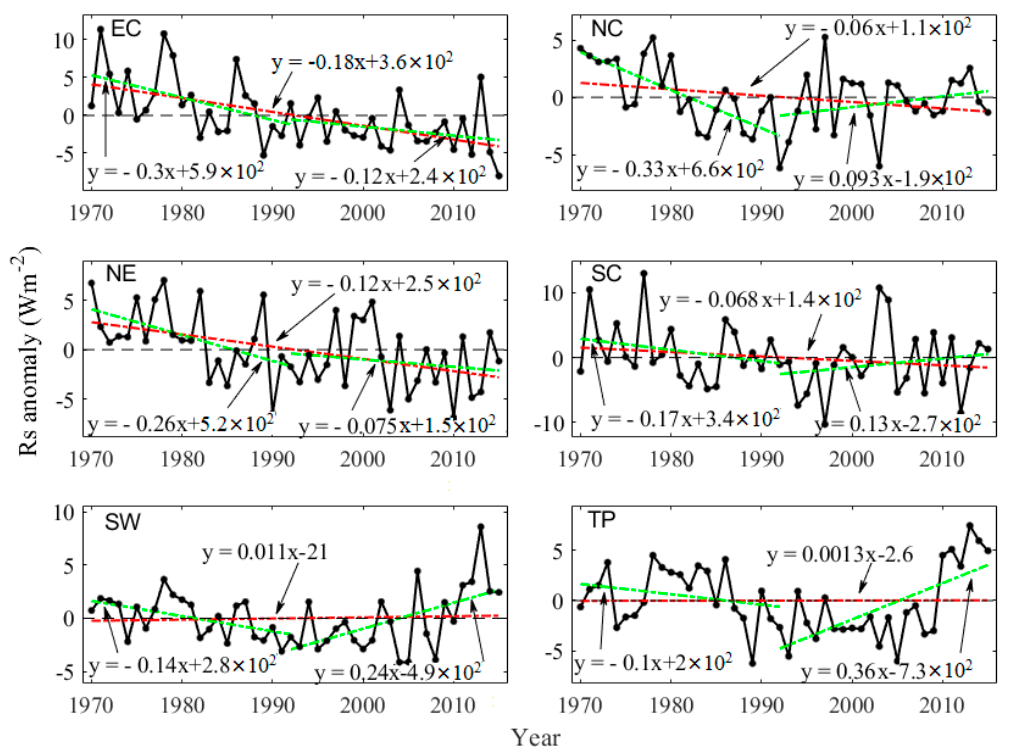
Figure 12. The anomaly of the annual mean Rs in six climatic regions during 1970–2015. The green dashed lines are linear trends of 1970–1992 and 1992–2015.